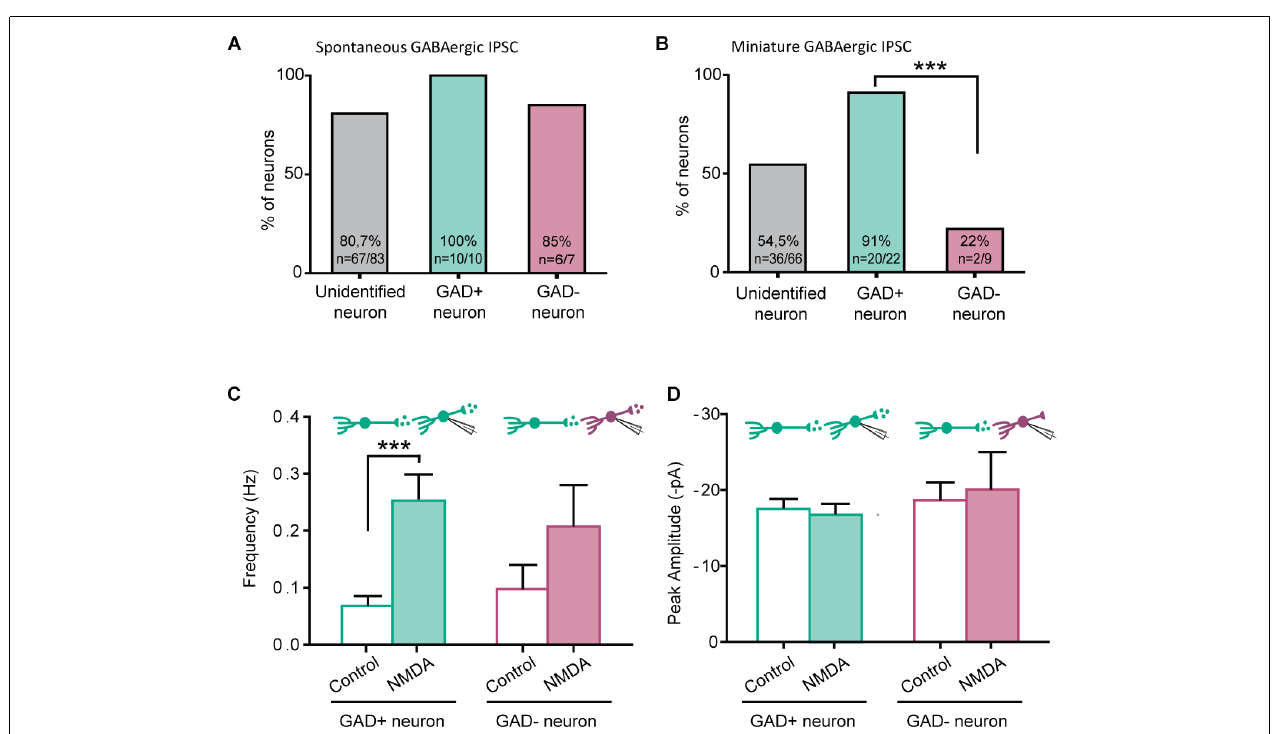
FIGURE 4 | NMDA enhancement of mIPSC frequency target specifically GABAergic interneurons. (A) Proportion of recorded neurons showing an increase of GABA sIPCS frequency by NMDA application, in unidentified neurons from C57bl6 mice and GAD positive (GAD+) or GAD negative (GAD-) neurons from GAD65-eGFP mice. (B) Proportion of recorded neurons recorded showing an increase of GABA mIPCS frequency by NMDA application is significantly higher in GAD positive (GAD+) neurons than for GAD negative (GAD-). (C,D) Frequency (C) and peak amplitude (D) of GABAergic mIPSCs recorded in GAD+ and GAD- neurons